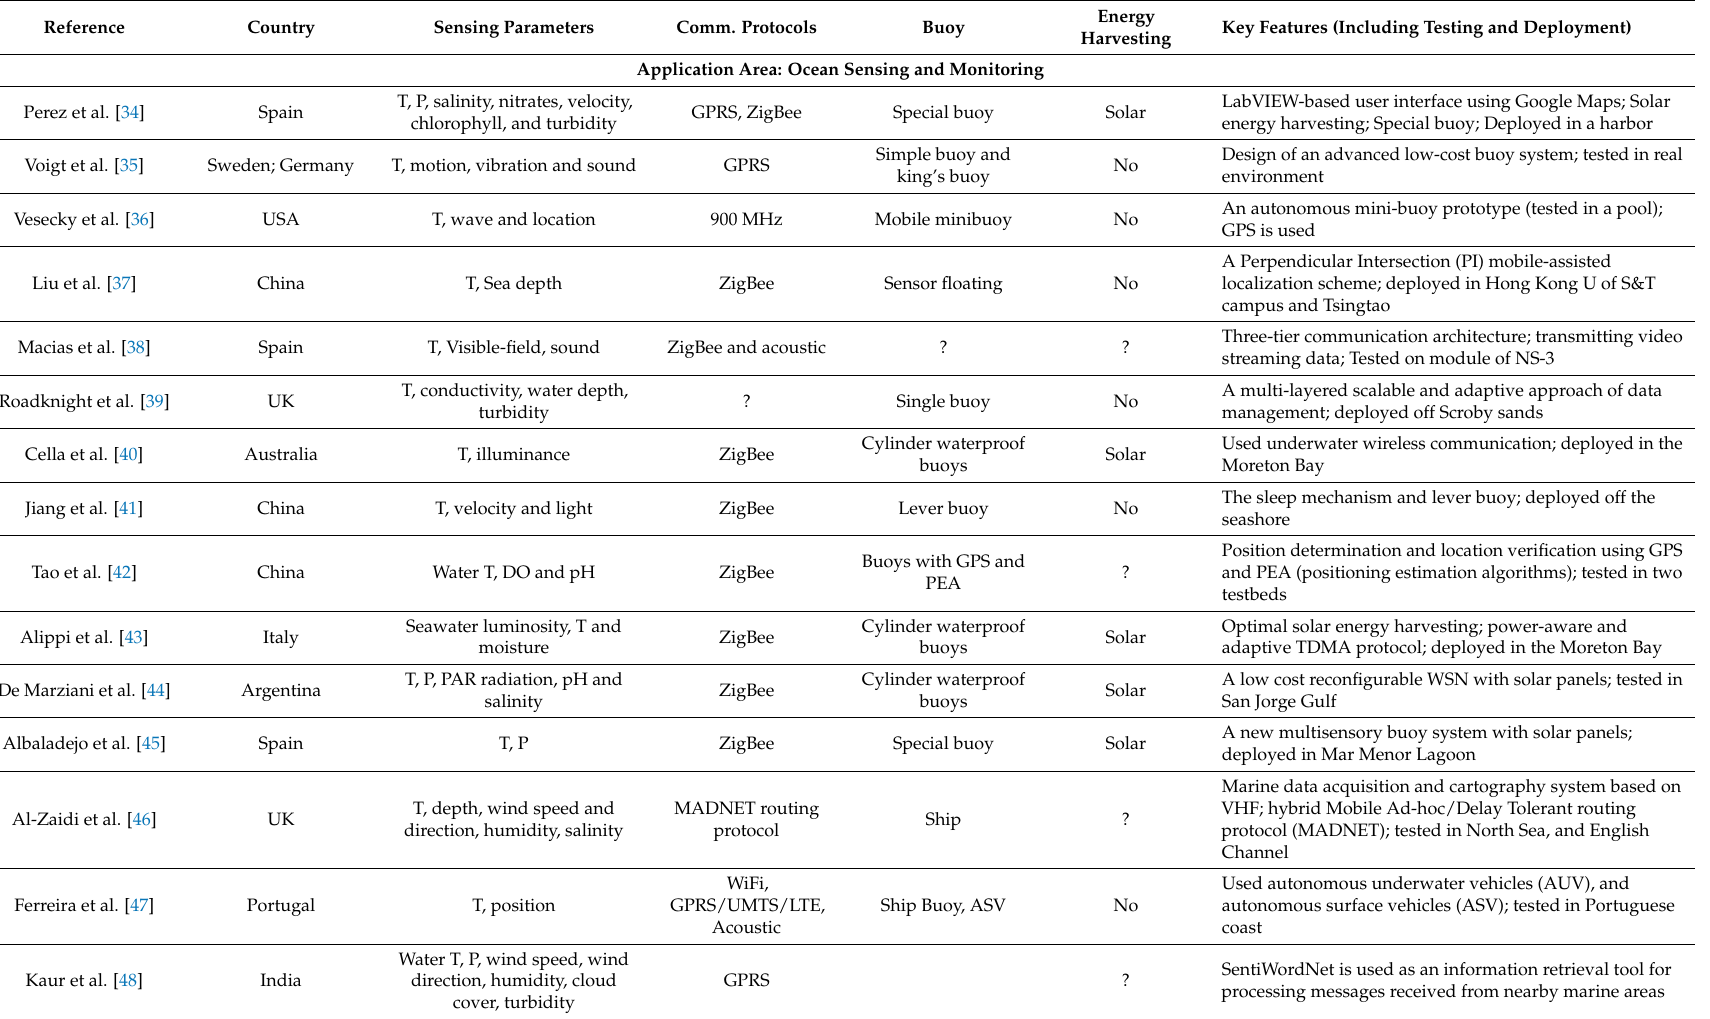
Table 1. Summary of existing marine environment monitoring projects and